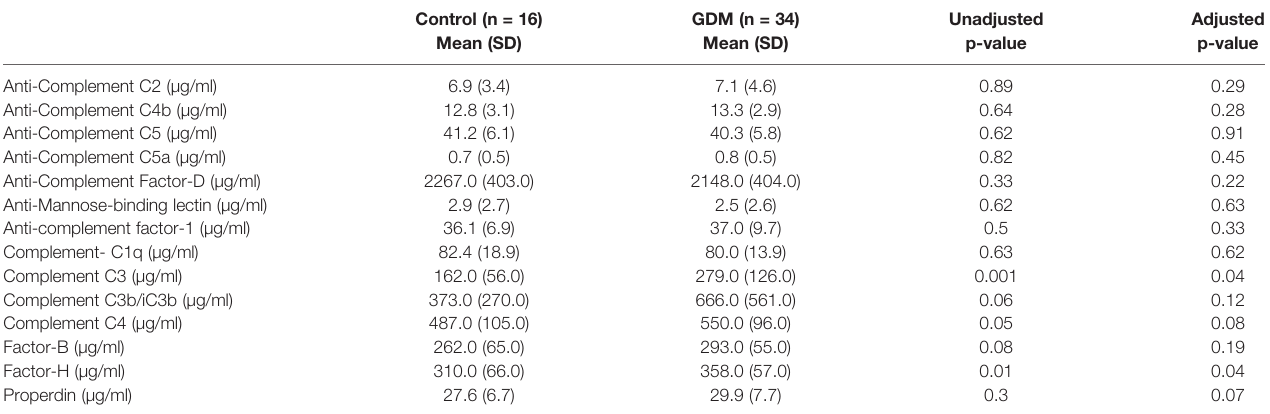
TABLE 2 | Complement and anti-complement levels in gestational diabetes (GDM) and control